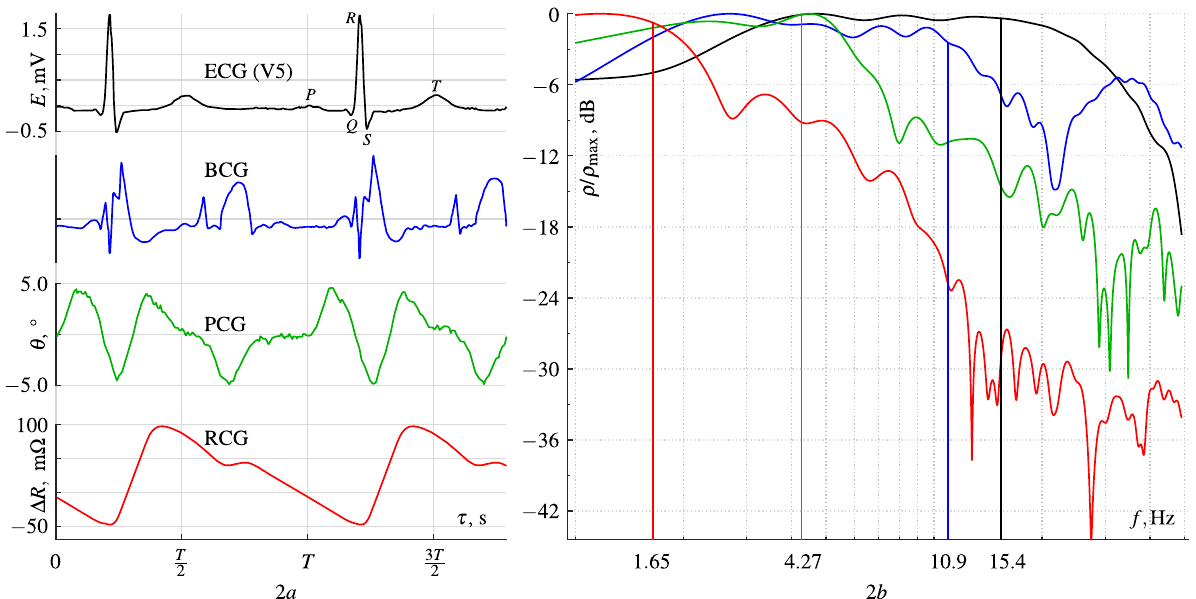
Figure 2. Graph 2 a shows the polarimetric cardiogram (PCG, green) we have recorded synchronously with a standard ECG in V5 lead (black) and rheocardiogram (RCG, red) combined with the ballistocardiogram 25 (BCG, blue). Graph 2 b shows their normalized power spectra and corresponding median frequencies. The 0.78 heartbeat period T ≈